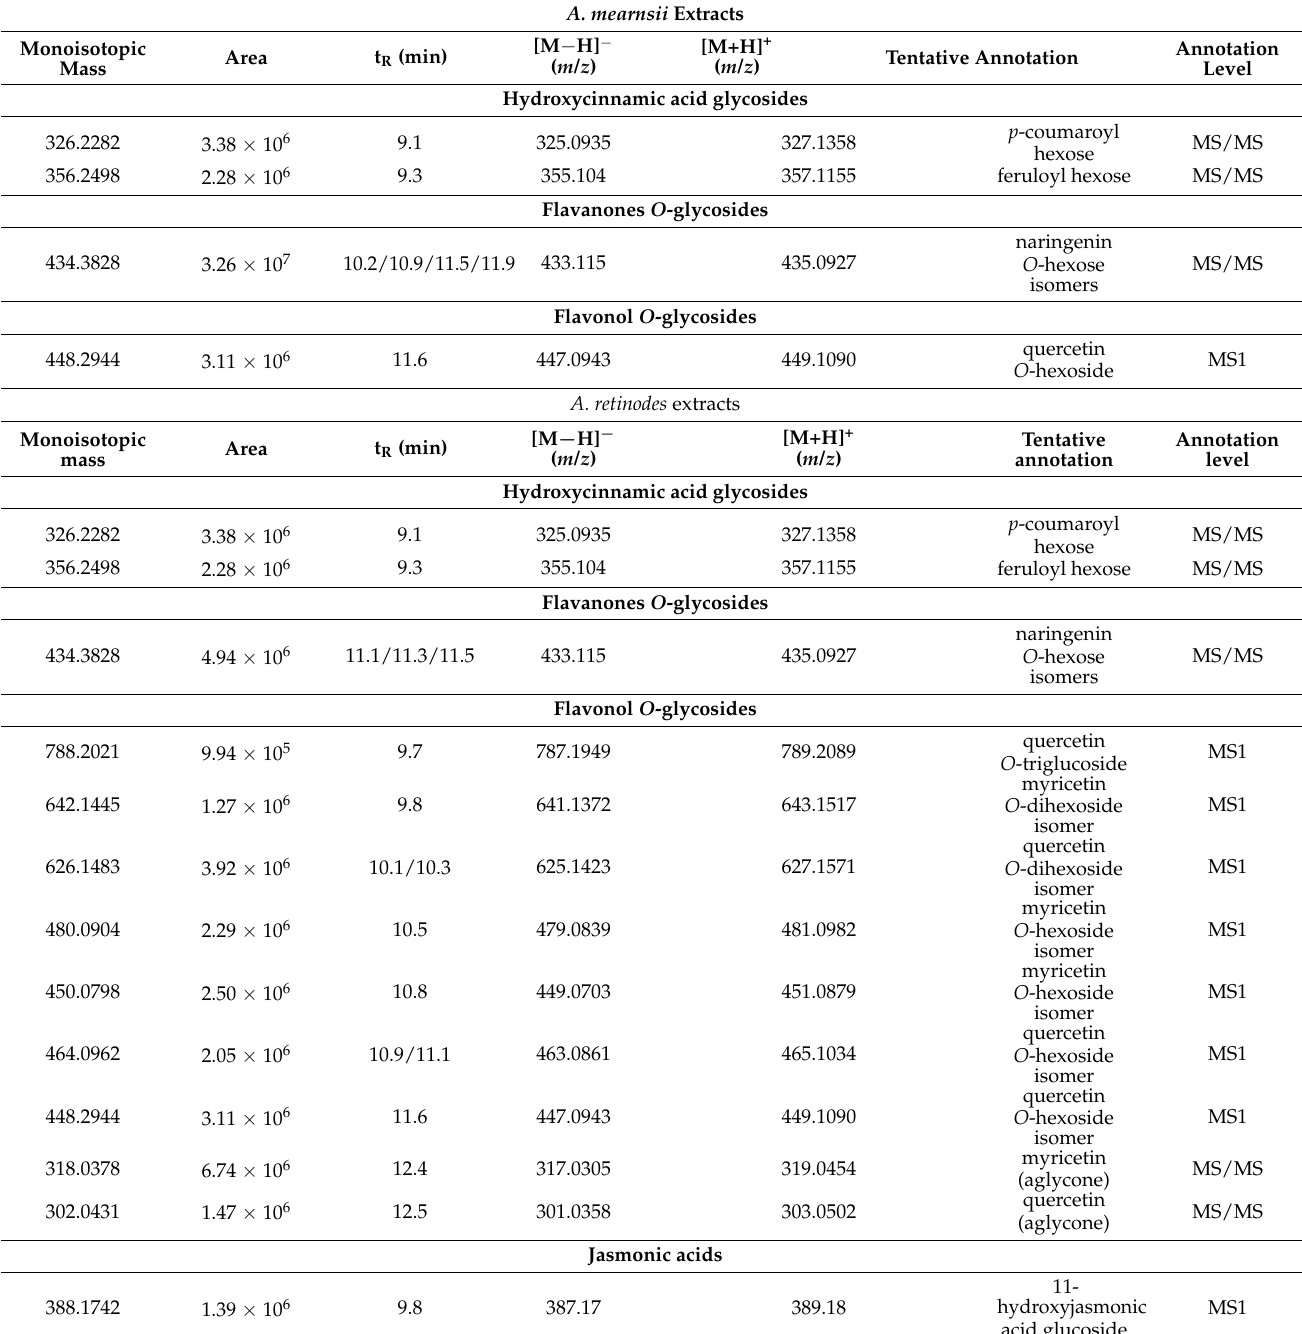
Table 6. Mass spectrum data and peak assignments for the most abundant compounds identified from the A. mearnsii and A. retinodes extracts, with annotation level